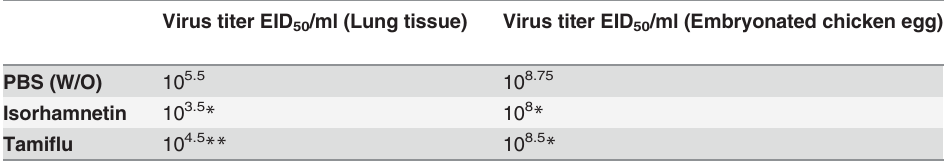
Anti-in fl uenza virus activity of the isorhamnetin against in fl uenza A/PR/8/34 (H1N1) in vivo by determining the virus titer in embryonated chicken egg and in mice lung tissues that represented in EID 50 (50% embryo infectious